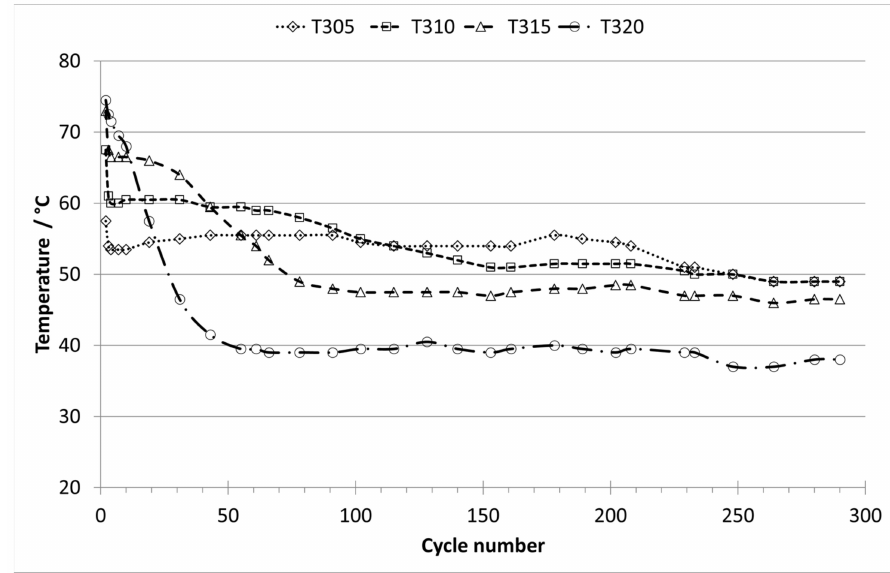
Figure 6. Dependence of the temperature behavior on the cycle number for E0/humid N 2 .